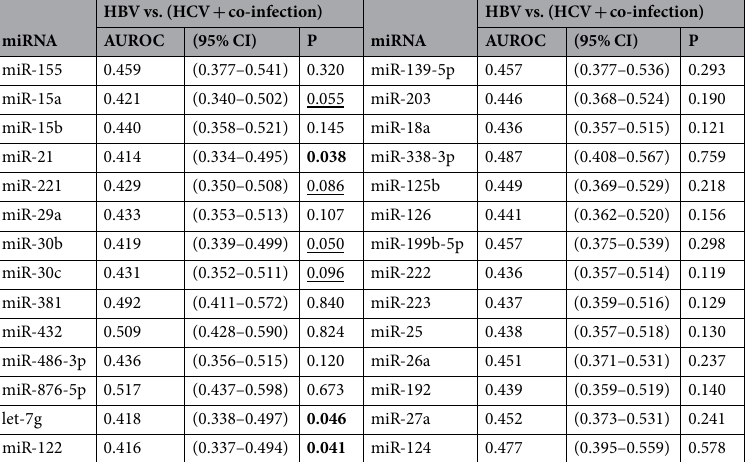
Table 4. Univariate analysis of associations between miRNA levels and viral etiology. A total of 7 miRNAs reached a significance level of 0.1 (underscored). Among them, 3 miRNA has P < 0.05 (shown in bold